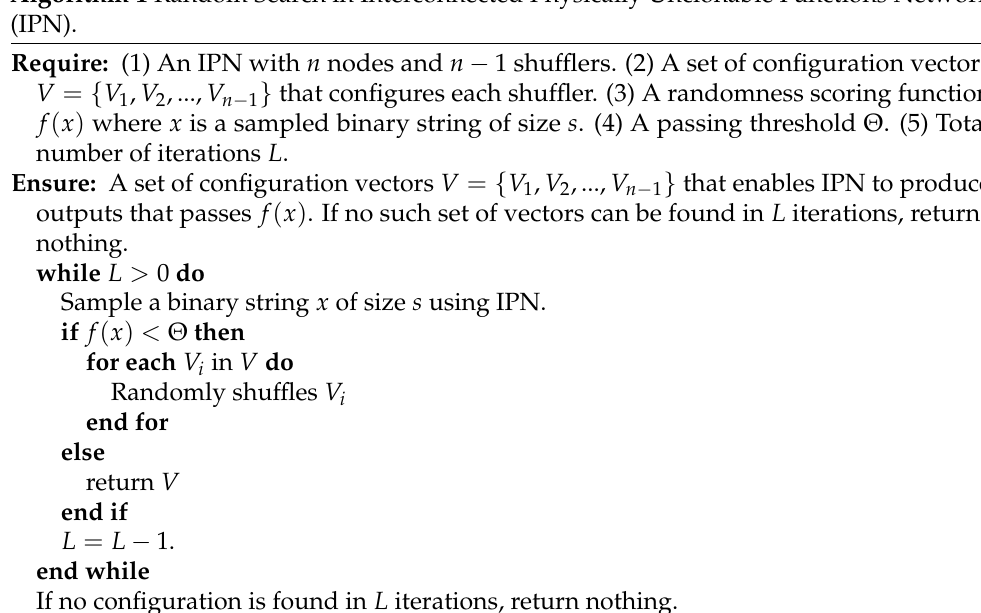
Algorithm 1 Random Search in Interconnected Physically Unclonable Functions